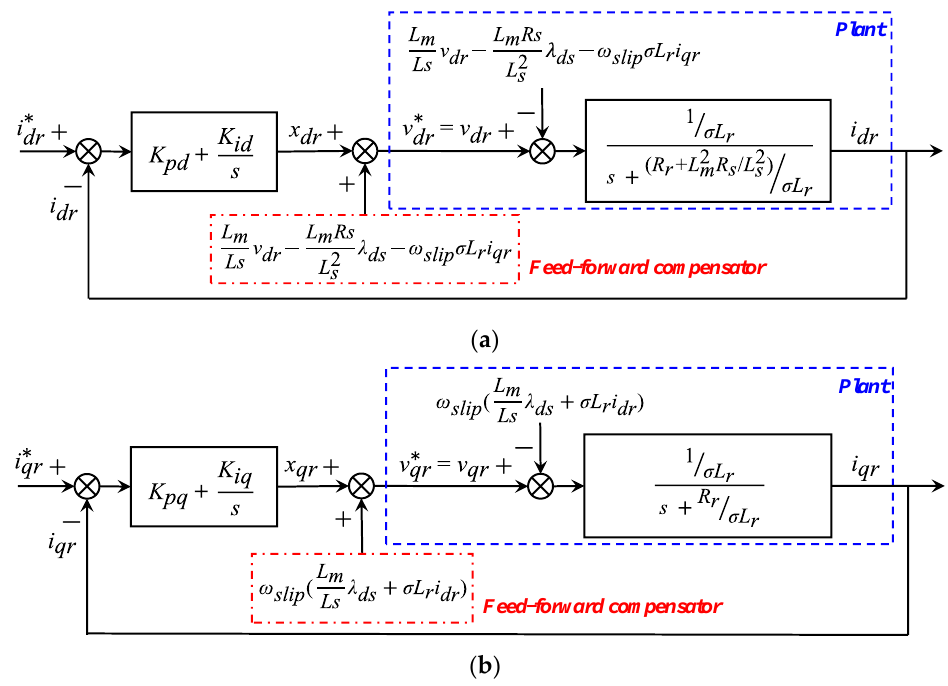
Figure 3. Rotor current regulators and feed-forward compensators. ( a ) d -axis current regulator. ( b ) q -axis current regulator. 2.2. Non-Linear Model of the Real and Reactive Power Controller The commands for d -axis and q -axis current regulators, i ∗ determined by the real and reactive power controller as described in Figure 4.